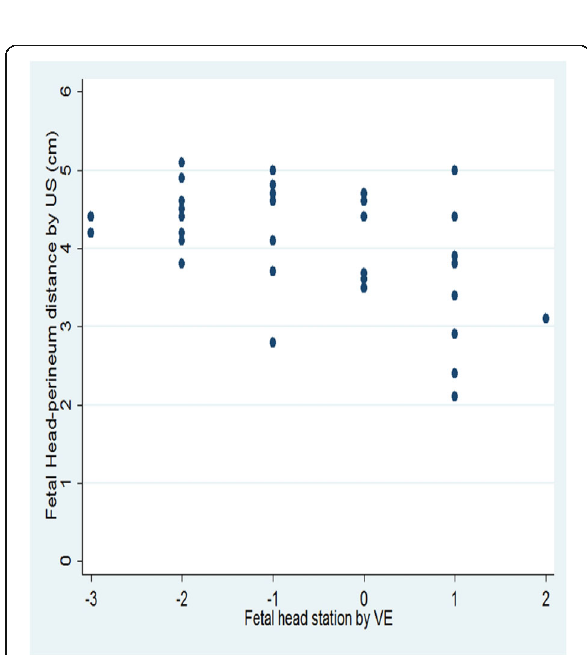
Fig. 10 Scatter plot showing correlation between fetal head station by VE and fetal HPD by